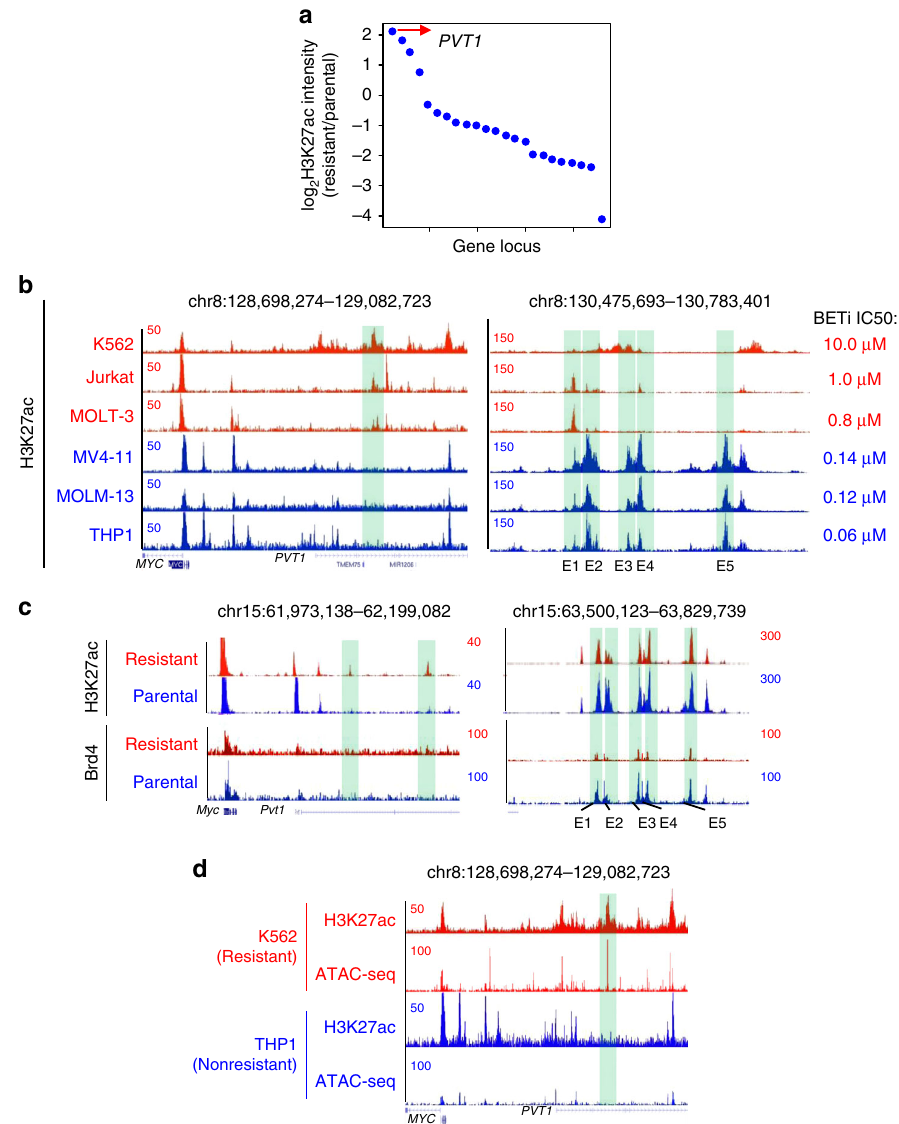
Fig. 5 A de novo remodeled PVT1 enhancer in BETi-resistant leukemia cells. a Differential enrichment of H3K27ac at all identi fi ed MYC enhancers between parental (sensitive) and BETi-resistant murine AF9 AML cells. Red arrow: The genomic region within Pvt1 locus at the top differential enriched regions between parental and BETi-resistant murine AF9 AML cells. b Genome browser views of H3K27ac enrichment in the PVT1 locus (left) and BENC enhancers (E1 – E5, right) of MYC in the indicated leukemia cell lines with relatively high (red) or low (blue) IC 50 values of BETi. Green highlighted regions represented MYC enhancers. c Genome browser view of H3K27ac enrichment at Myc Pvt1 locus (top) and BENC enhancers (E1 – E5, bottom) in BETi- sensitive (Vehicle, blue) and resistant (red) murine AF9 AML cells. Green highlighted regions were identi fi ed MYC enhancers. d Genome browser views of H3K27ac and ATAC-seq signals of MYC PVT1 enhancers in K562 (red) and THP1 (blue) cells. Green highlighted regions were identi fi ed MYC